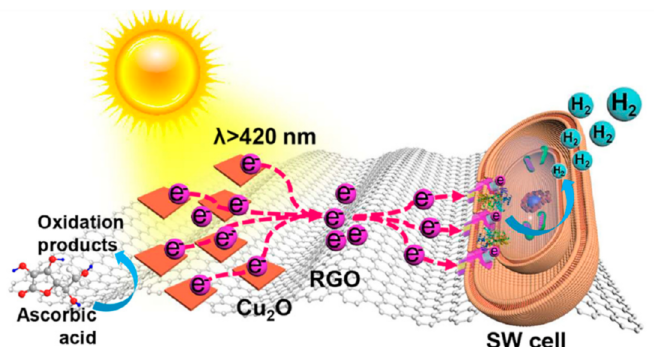
Figure 24. Schematic illustration of charge separation and transfer giving rise to hydrogen evolution under visible light irradiation in an RGO-based bio-hybrid including Shewanella oneidensis (SW) bacteria. Reproduced from [135] with the permission of the American Chemical